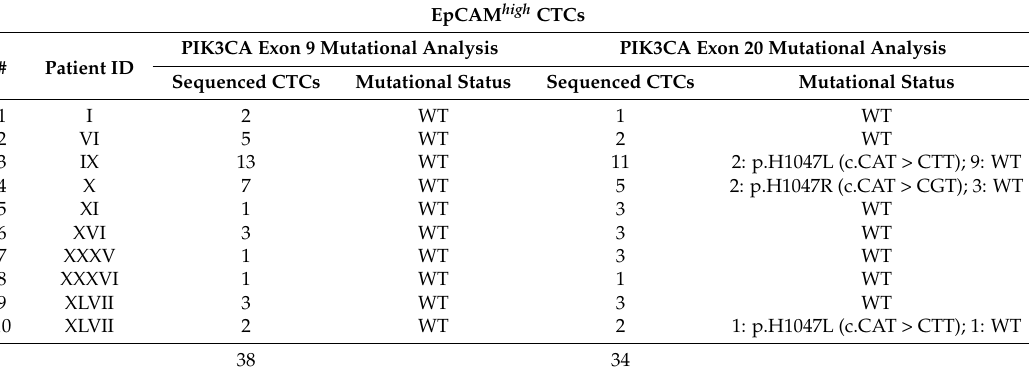
Table 2. Mutational status of PIK3CA exon 9 and exon 20 within patient-matched EpCAM high EpCAM low/negative